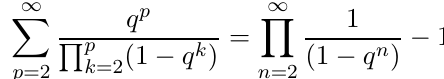
. Increasing N corresponds to adding more ∞ , with k already taken to , ∞ ∞ e W ∞